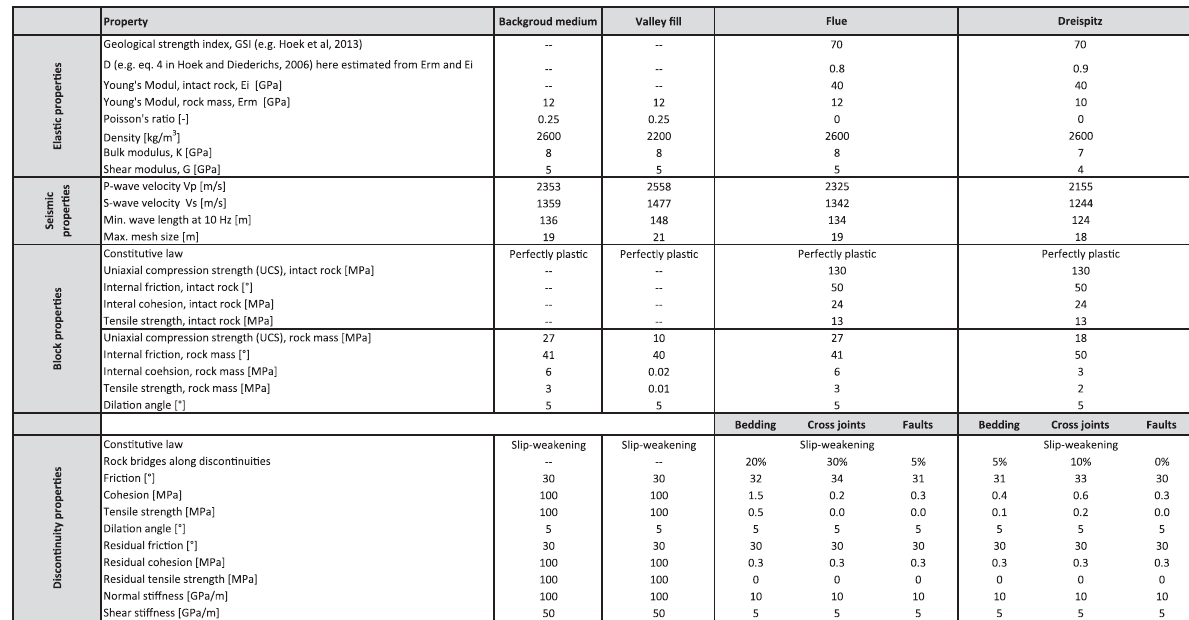
TABLE 1 | Elastic and strength properties of the rock mass shown in Figures 7A,B